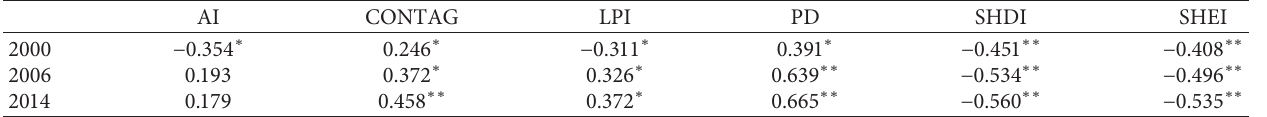
Table 6: Correlation coefficients between landscape-level metrics and LST.